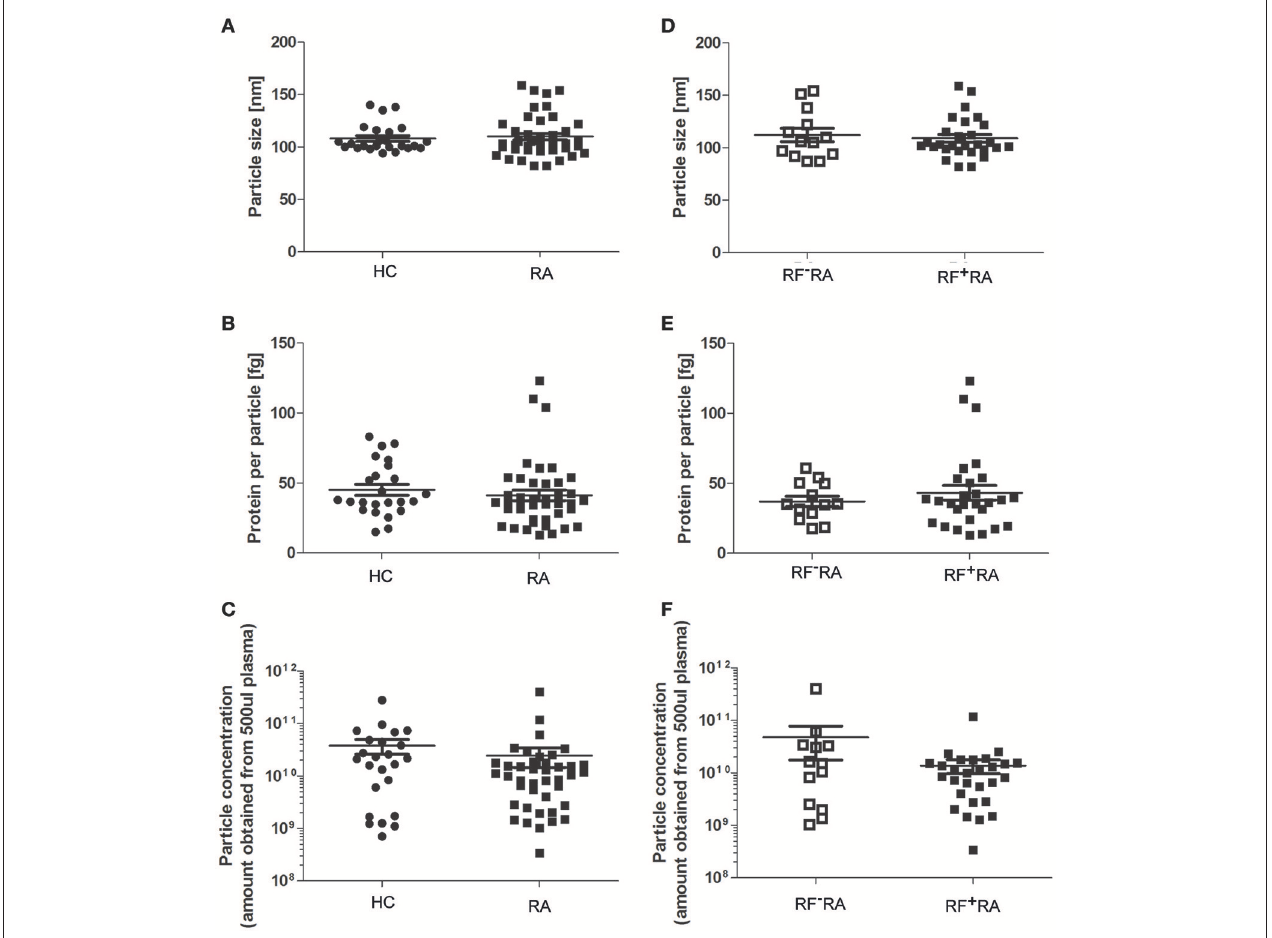
FIGURE 2 | Characterization of pEVs from healthy controls and RA patients. Mode particle size (A) , protein content per particle (B), and amount of particles (C) from pEVs isolated from 500 µ l pfp of HC ( n = 24) or RA patients ( n = 41) were measured by NTA and micro-BCA protein assay. Next, RA patients were divided in 2 groups based on the presence of IgM-RF (RF + RA; n = 28 and RF − RA; n = 13). Particle size (D) , protein per particle (E) and amount of particles (F) of isolated pEVs are shown measured by NTA and micro-BCA protein